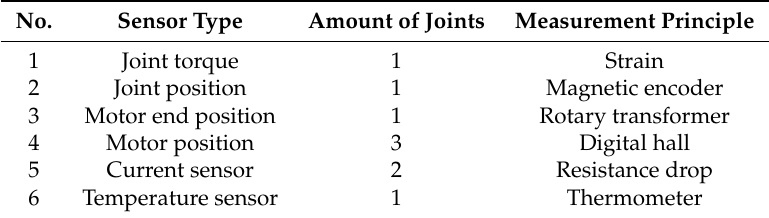
Table 1. Sensor configuration of the arm